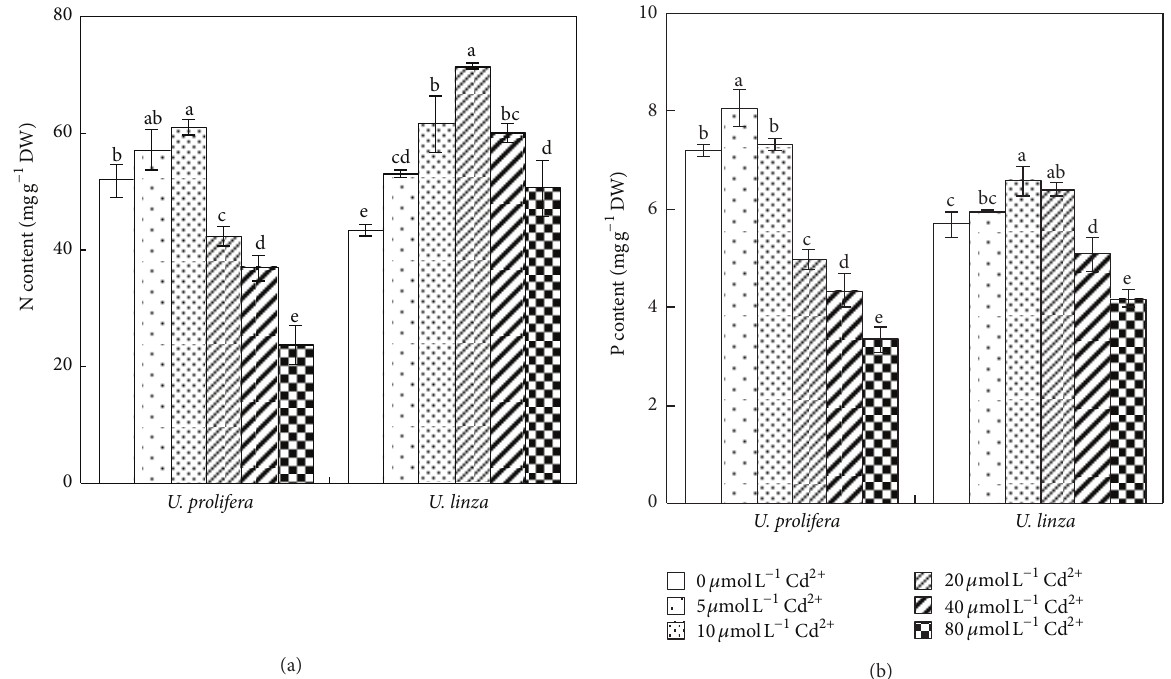
Figure 6: Effects of different concentrations of Cd 2+ (0, 5, 10, 20, 40, 80 𝜇 molL −1 ) on contents of N (a) and P (b) of U. prolifera and U. linza.